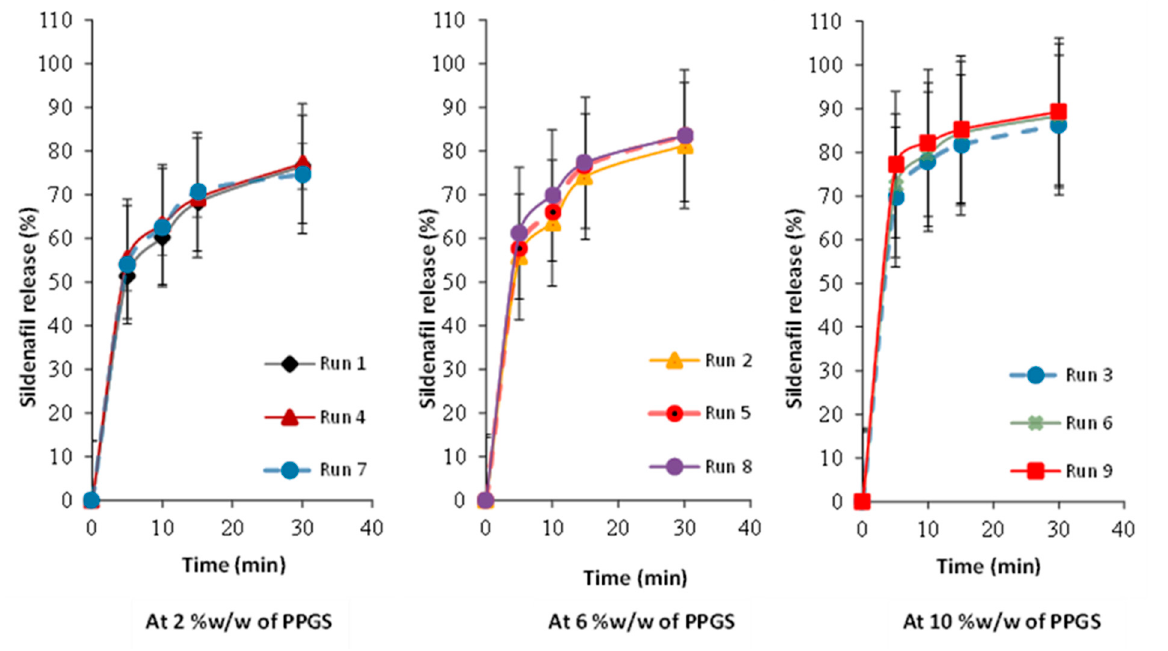
Figure 4. In vitro release profiles of sildenafil ODMTs based on 3 2 Full-Factorial Design.